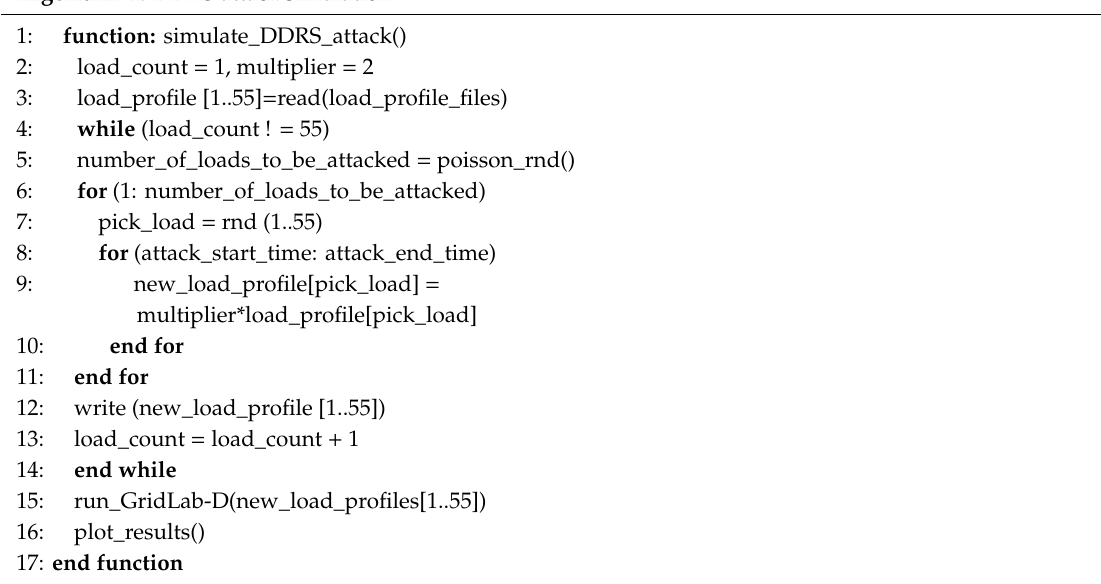
Algorithm 1: DDRS attack